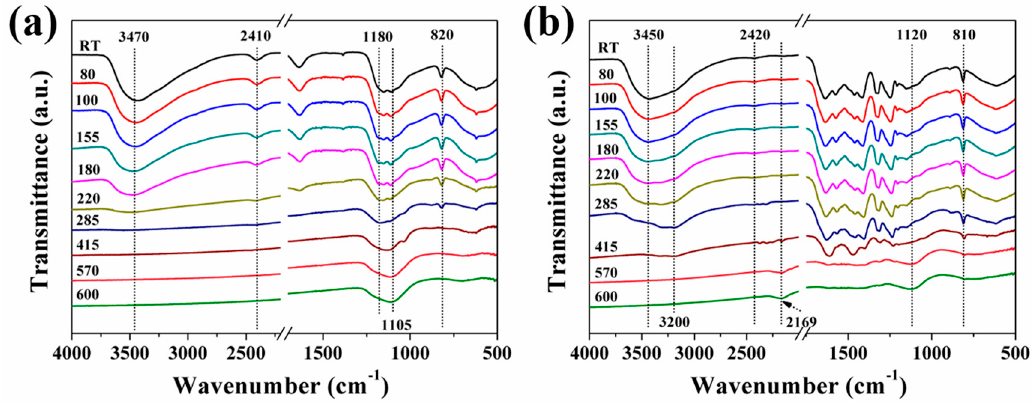
Figure 8. Real-time Fourier transform infrared spectroscopy (RTFTIR) spectra for condensed products of ( a ) AHPi and ( b ) CAHPi20. RT: Real-time.